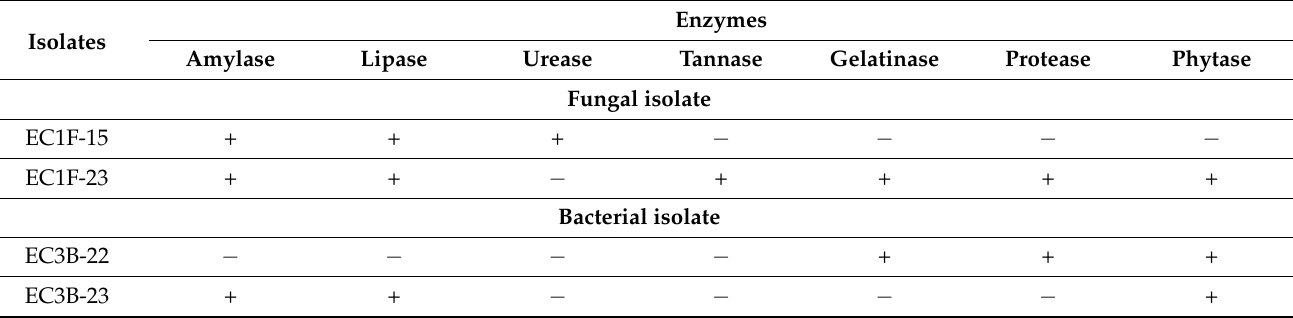
Table 3. Extracellular enzymes produced by